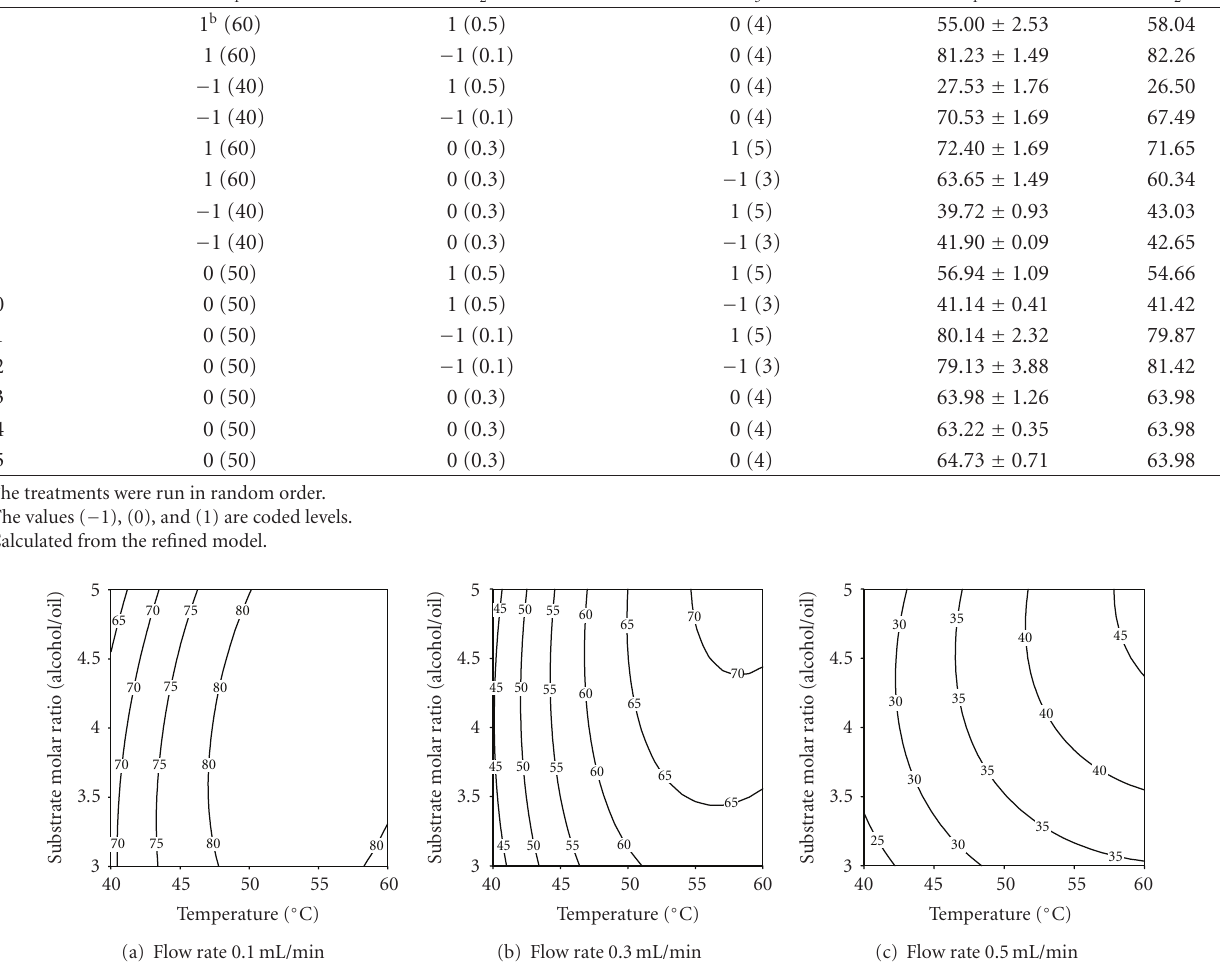
Figure 2: Contour plots of molar conversion of continuous synthesized fatty acid methyl esters. Reaction conditions: constant flow rate with 1.7g enzyme. Numbers inside the plots indicate the molar conversion at given reaction conditions.